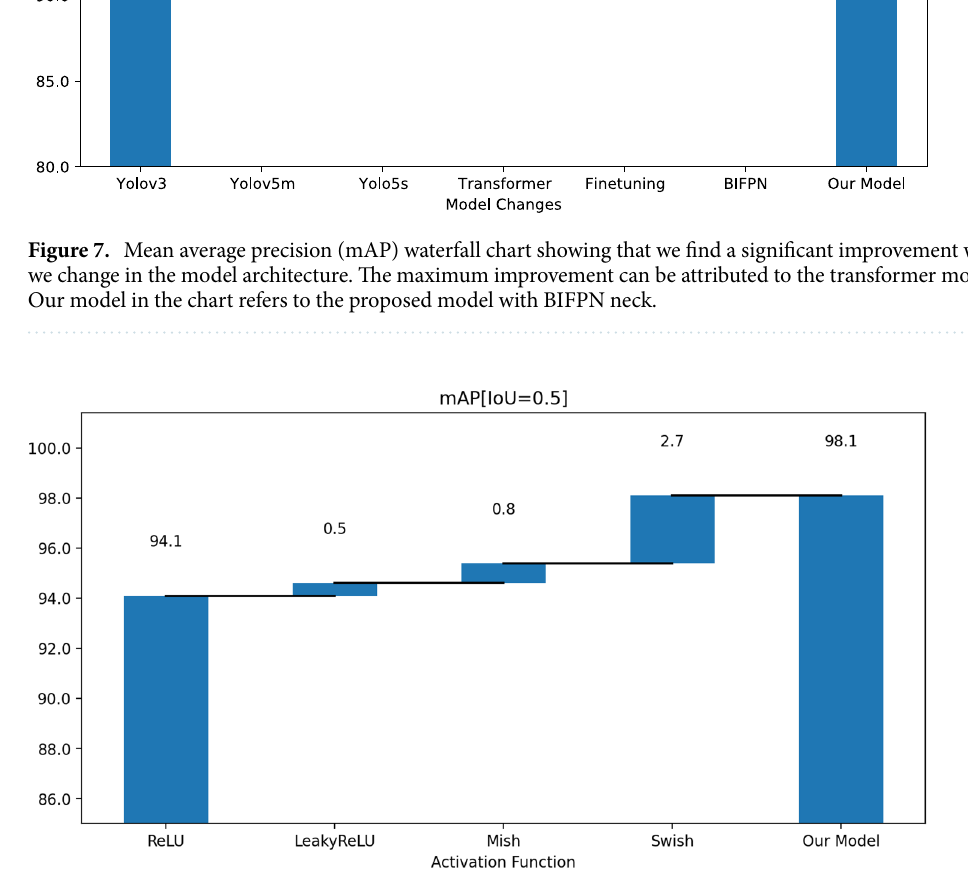
Figure 8. Mean average precision (mAP) waterfall chart showing the effect of changing the activation functions on the model. We find a significant improvement when we use the Mish activation function. The Swish activation function yields the best improvement in our